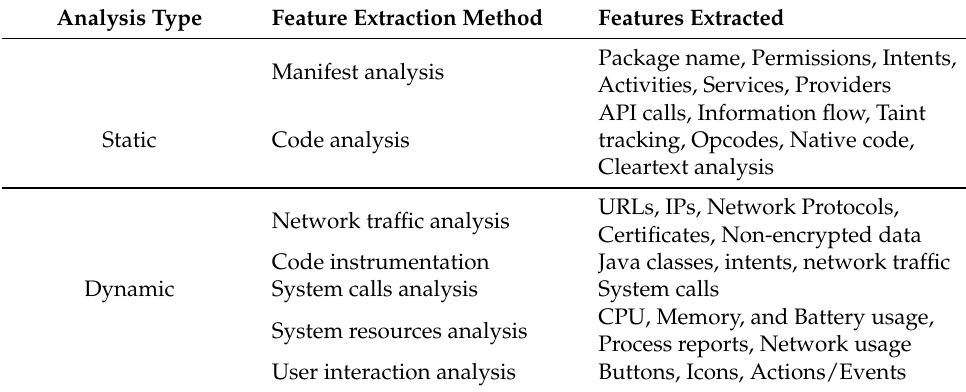
Table 1. Feature extraction options per analysis